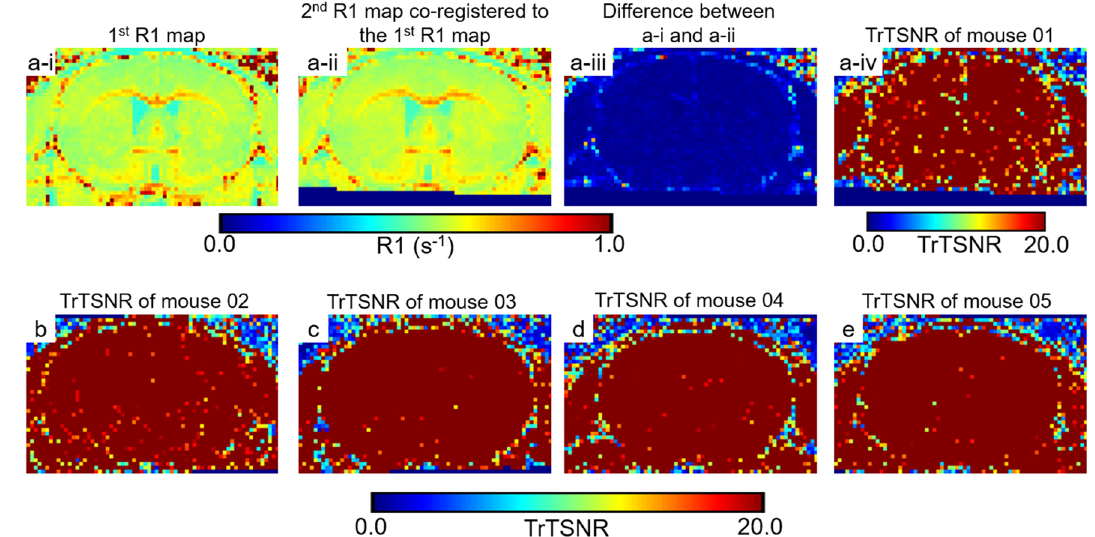
Figure 5. Reproducibility of R1 (1/T1) mapping. After saturation-based co-registration, all T1 (s) maps were converted into R1 (s −1 ) maps where R1 is defined as 1/T1. ( a-i ) R1 map using MP2RAGE. ( a-ii ) Repeat R1 map from a second acquisition in the same mouse, co-registered to the map from the first scan. ( a-iii ) ΔR1 map for each voxel, defined as R1 from scan 2–R1 from scan 1 after co-registration. ( a-iv ) test–retest signal to noise ratio (TrTSNR) map, defined at each voxel as the average R1 between the 2 scans divided by ΔR1. ( b – e ) TrTSNR maps for 4 additional mice. TrTSNR = 20 represents 95% reproducibility or 5% error. In all five control mice, TrTSNR of 20 or higher was observed.